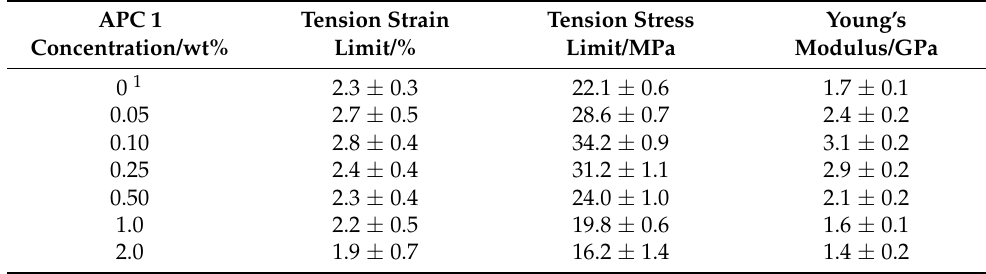
Figure 11. Tensile stress–strain curves for PMMA composites containing 0.05, 0.10, 0.25, 0.50, 1.0, and 2.0 wt% MPC 1, with that for PMMA provided as a reference. Table 1. Tensile mechanical properties of PMMA composites containing 0.05, 0.10, 0.25, 0.50, 1.0,